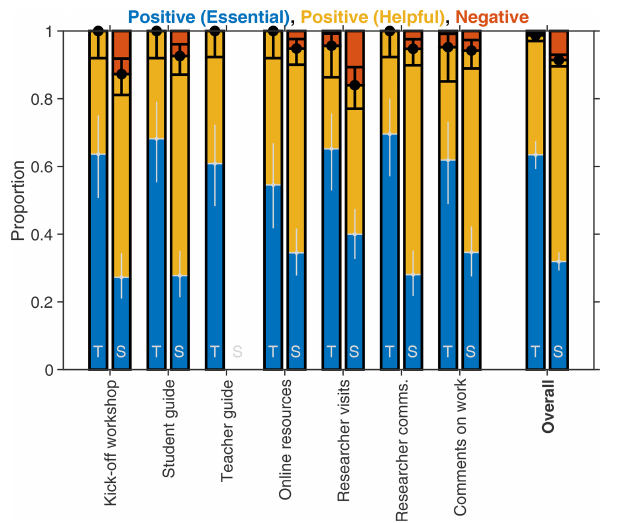
Figure 5. Usefulness of support provided to teachers (T, n = 23) and students (S, n = 68). Results are divided (black lines and asso- ciated error bars) into negative (red) and positive responses, with the latter subdivided (grey lines and error bars) into “essential” (blue) and “helpful” (yellow) elements. Error bars denote standard (1 σ ) Clopper and Pearson (1934)